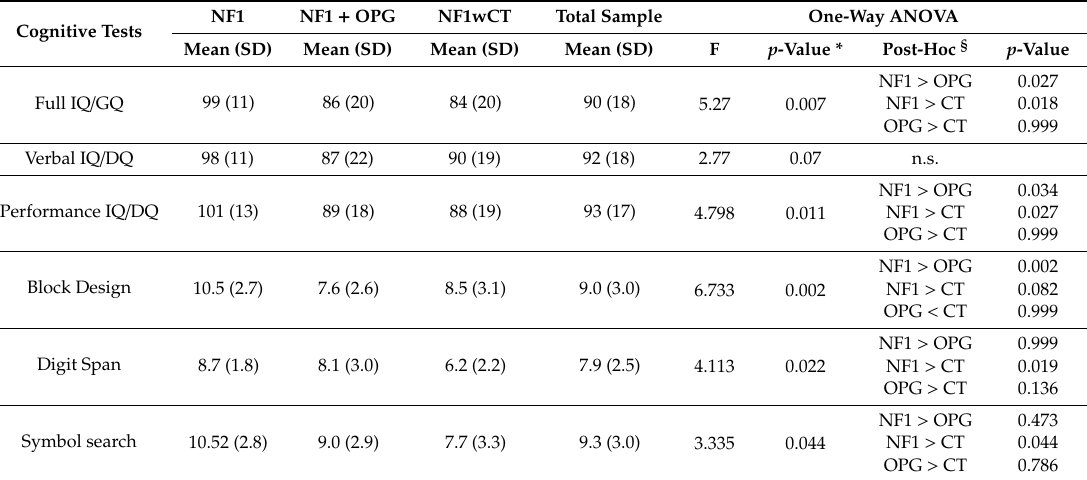
Table 1. Group comparison at the Intelligence and Developmental